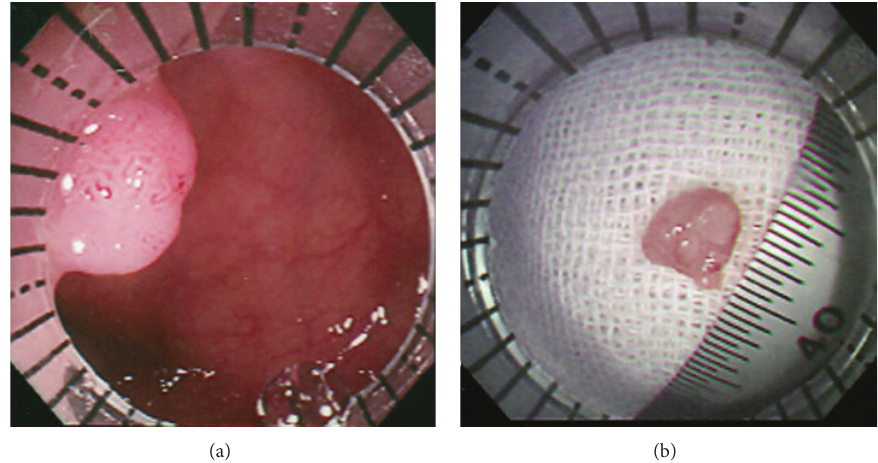
Figure 3: (a) A sessile polyp with a diameter of 6mm was measured using the side method. (b) The retrieved polyp with a diameter of 5 mm was measured using a